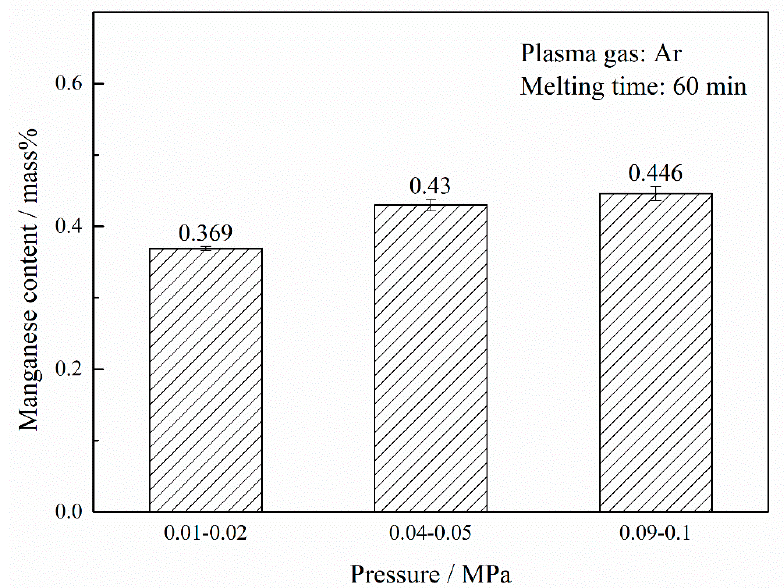
Figure 4 Manganese content after PAM under different pressures. Figure 4. Manganese content after PAM under different